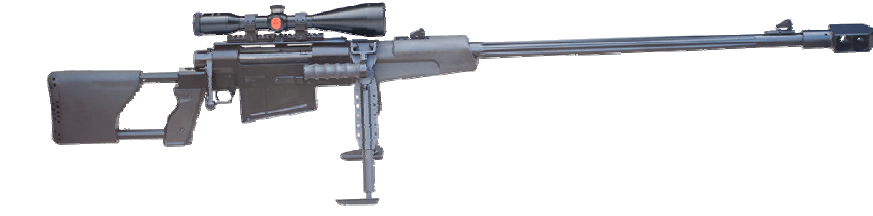
Figure 2 – Sniper rifle Zastava M93 Black Arrow equipped with the M94 optical sight (Zastava arms,